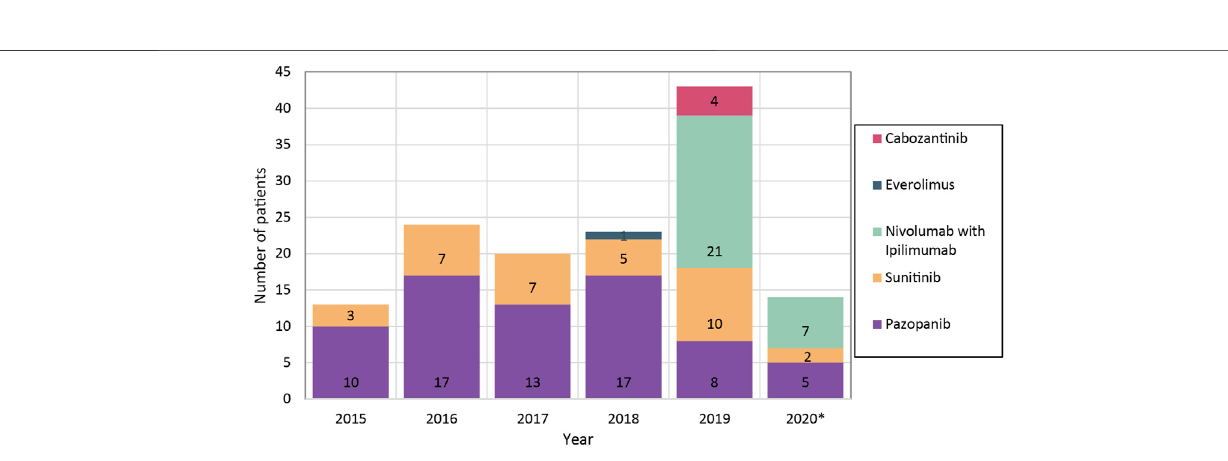
Frontiers in Pharmacology |